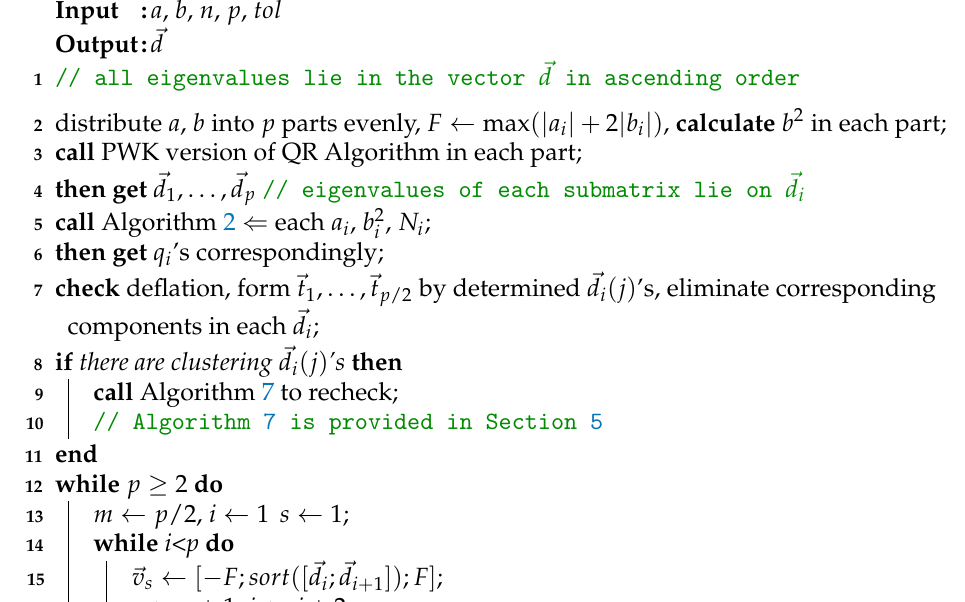
Algorithm 5: Computing all ST Eigenvalues